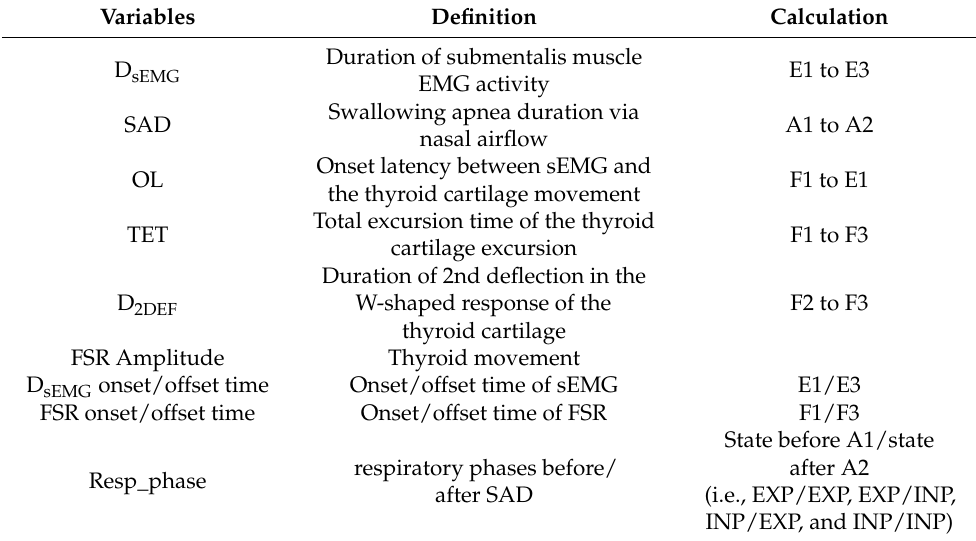
Table 1. Variables about the respiration and swallowing signals.